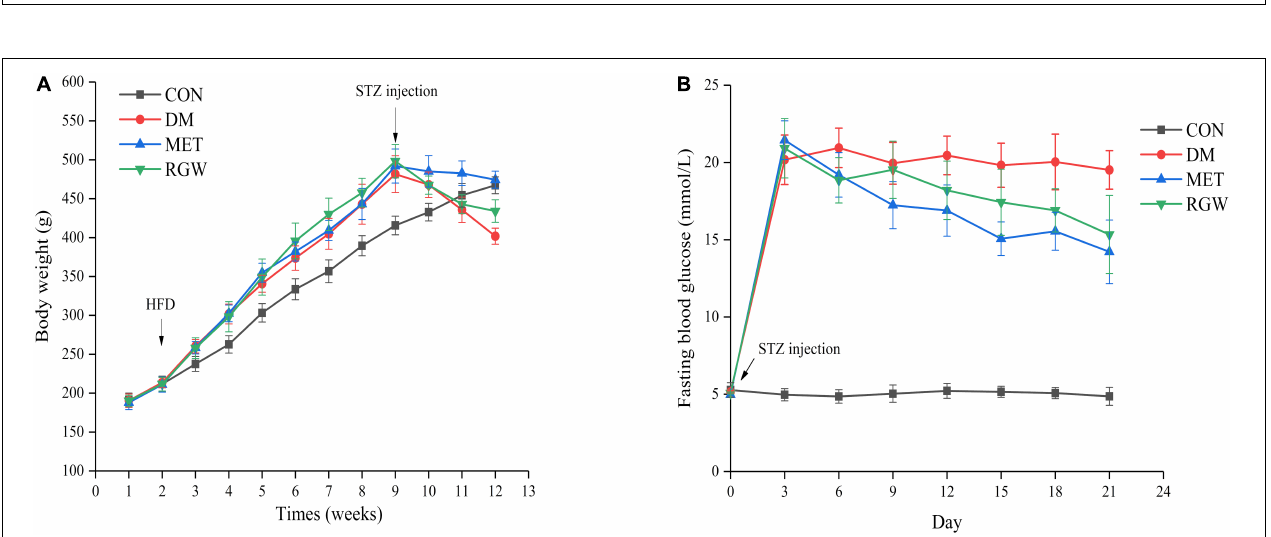
Frontiers in Nutrition |